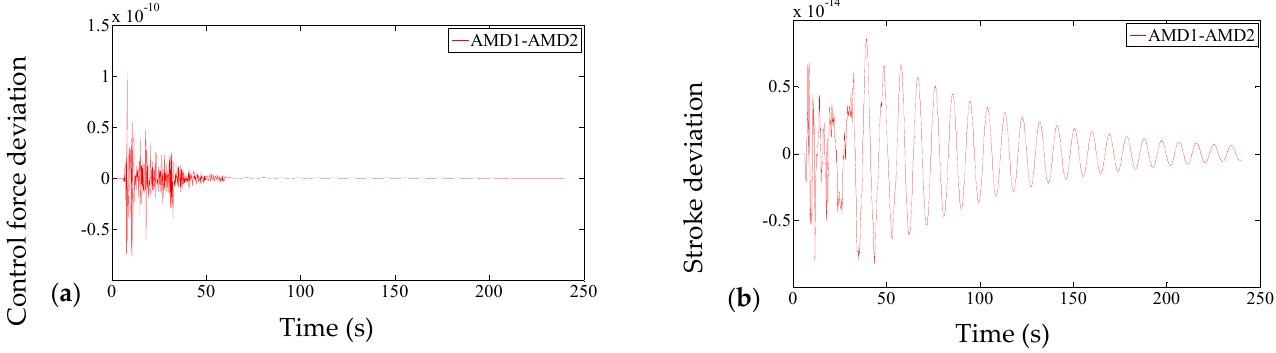
Figure 6. The deviations to the control parameters of System2 with equal time delays, ( a ) the forces and ( b ) the strokes.